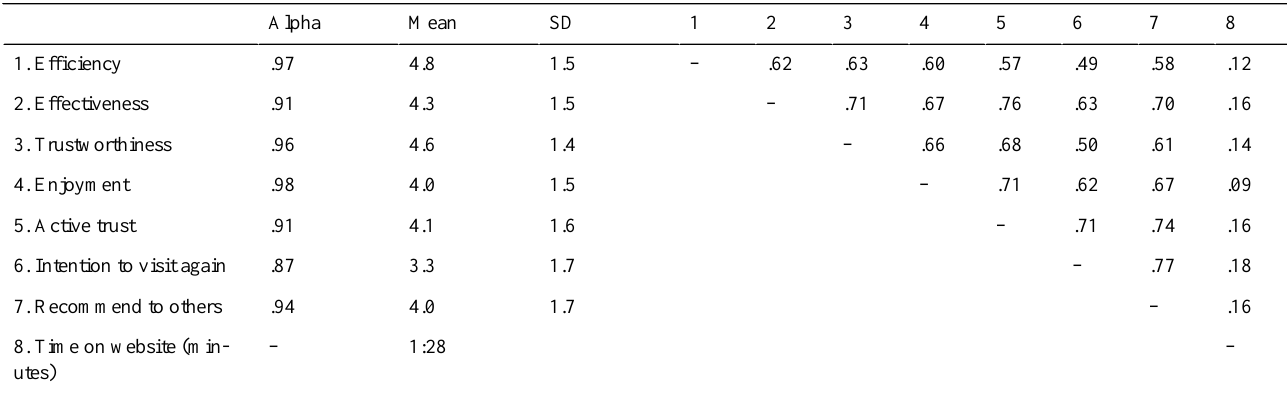
Table 2. Correlation matrix intervention 2 (N =